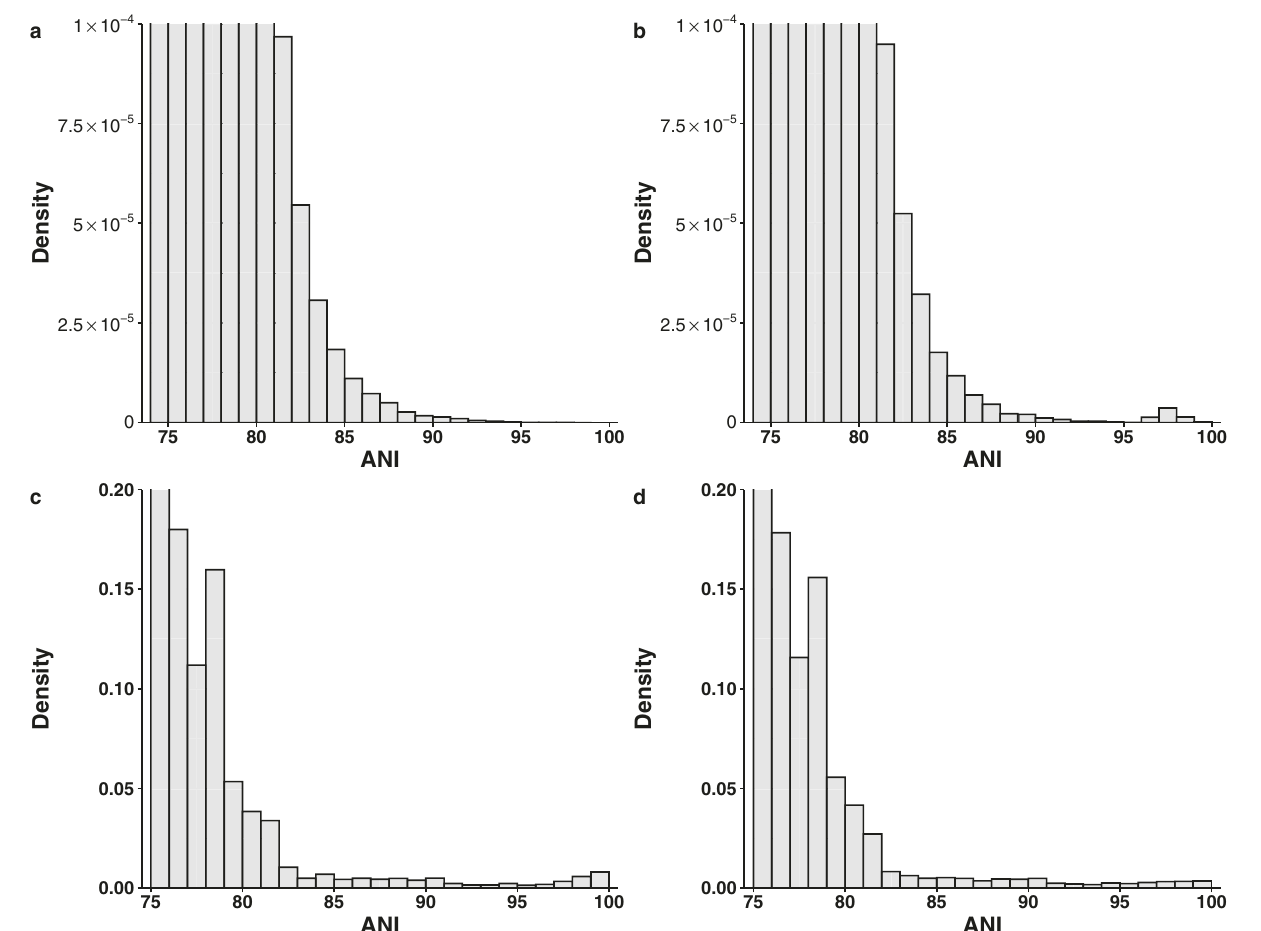
Fig. 1 Distribution of ANI values. Top panel: from the phylogenetic simulations. a Comparisons between 3000 taxa simulated using a phylogenetic tree with 3000 tips and a constant rate of diversi fi cation. b Comparisons in the same dataset except that 30 of 3000 taxa each have two very closely related genomes sequenced. Bottom panel: from genomes subsampled from the 90K genome dataset. c Two genomes were randomly selected from each of the 397 named species with ≥ 10 genomes. d Two phylogenetic representative genomes were selected for each of the 397 named species with ≥ 10